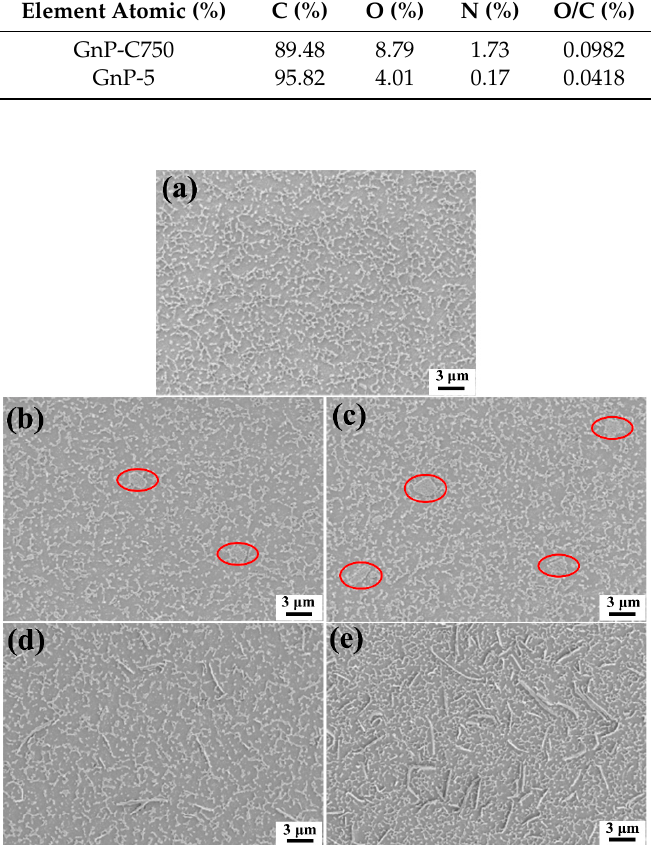
Figure 5. Dispersion of GnPs in PES/epoxy composites:( a ) without GnPs, ( b ) 1 wt % GnP-C750, ( c ) 3 wt % GnP-C750, ( d ) 1 wt % GnP-5, ( e ) 3 wt % GnP-5.